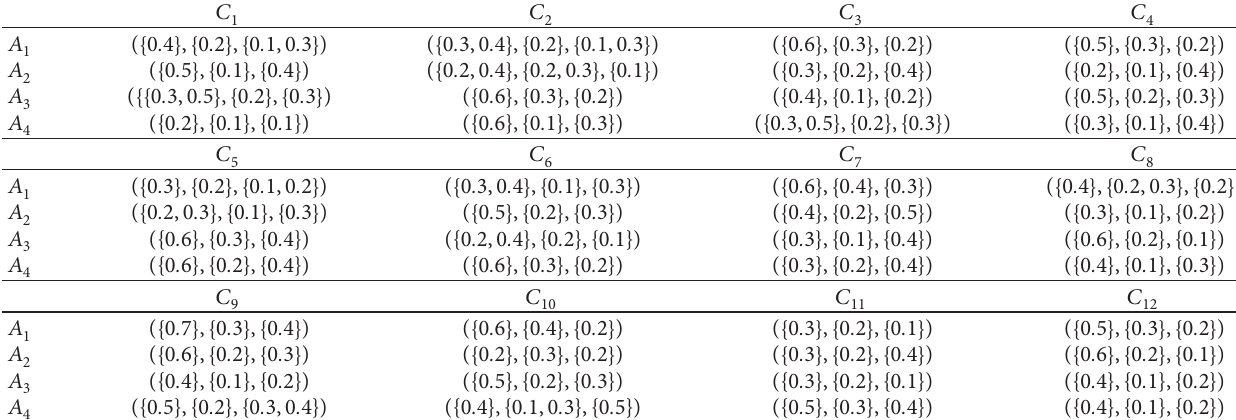
Table 1: Single-valued neutrosophic hesitant fuzzy